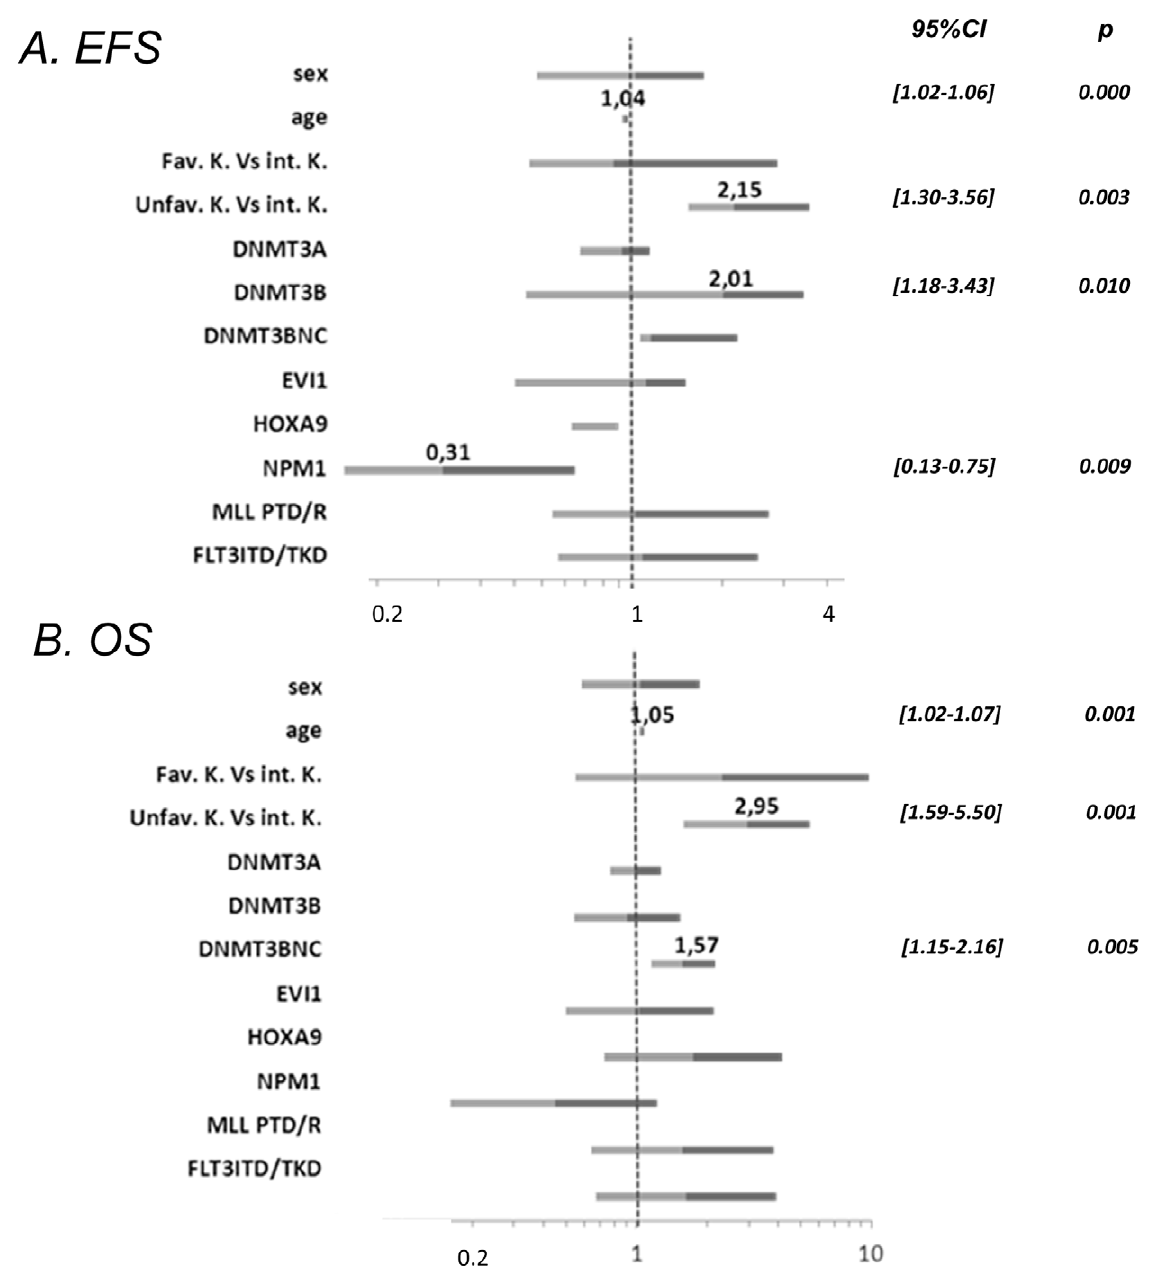
Figure 8. Multivariate analysis of High DNMT3B/3B NC expression as prognostic factors. Forest plot of multivariate analysis. Covariates tested in multivariate Cox models were sex, age, DNMTs, HOXA9, EVI1 expressions, and cytogenetic subgroups: favourable karyotype (Fav. K.) and unfavourable karyotype (Unfav. K.) versus intermediate karyotype (int.K.) for (A) event free survival (EFS) and (B) overall survival (OS). P values were calculated using the Cox regression model, significant p values (p , 0.05) are indicated Hazard Ratio are specified on the forest plot when p values are significant; CI, Confidence Interval (95%).